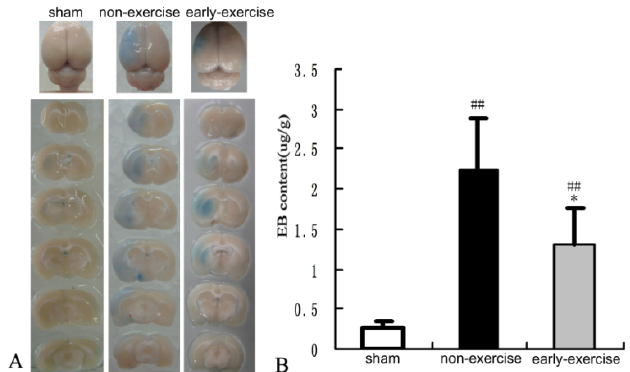
Figure 3. Effect of early exercise on Evans blue (EB) extravasation. ( A ) Representative images of EB-stained brains after three-day exercise; ( B ) Quantification of Evans blue dye (µg dye/g brain tissue). Compared to NE rats, early exercise significantly reduced the amount of EB in the ipsilateral hemisphere of early-exercise (EE) rats. * p < 0.05, compared with the non-exercise group; ## p < 0.01, compared with the sham group. n =